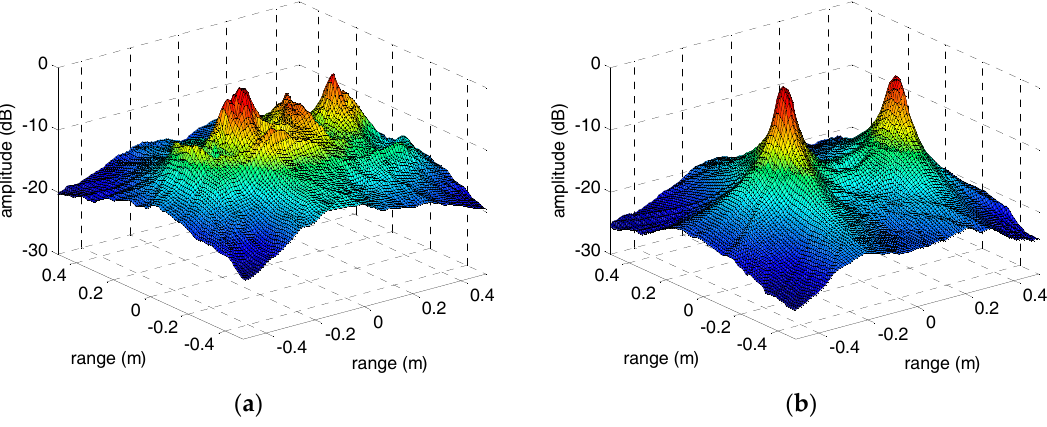
Figure 10. The IRT results of the corner reflectors’ HRRP sequences through adjacent correlation correction and our method. ( a ) The adjacent correlation correction. ( b ) The method in this paper.